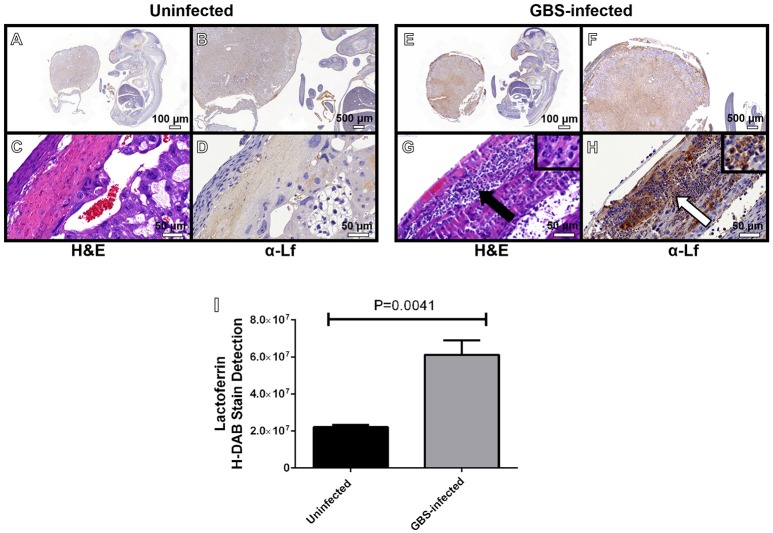
Microscopic analyses of the spatial localization of lactoferrin within uninfected (A–D) or GBS-infected (E–H) fetal-placental tissue. Representative micrographs collected at 4X (A,E), 20X (B,F), and 400X (C,D,G–H). Panels (A,B,D,E,F,H) indicate IHC staining with a mouse monoclonal antibody to lactoferrin (α-Lf). Panels (C,G) indicate hematoxylin and eosin staining (H&E) for immunopathology. Panel (I) quantification of anti-lactoferrin HDAB stain by ImageJ IHC toolbox reveals GBS infection results in elevated lactoferrin within the fetal-placental tissue (bars indicate mean quantified H-DAB stain ± SEM, P = 0.0041, Student's t-test, N = 3). Panels (G–H) demonstrate the preponderance of lactoferrin stain (white arrow) is associated with polymorphonuclear cells (black arrow).